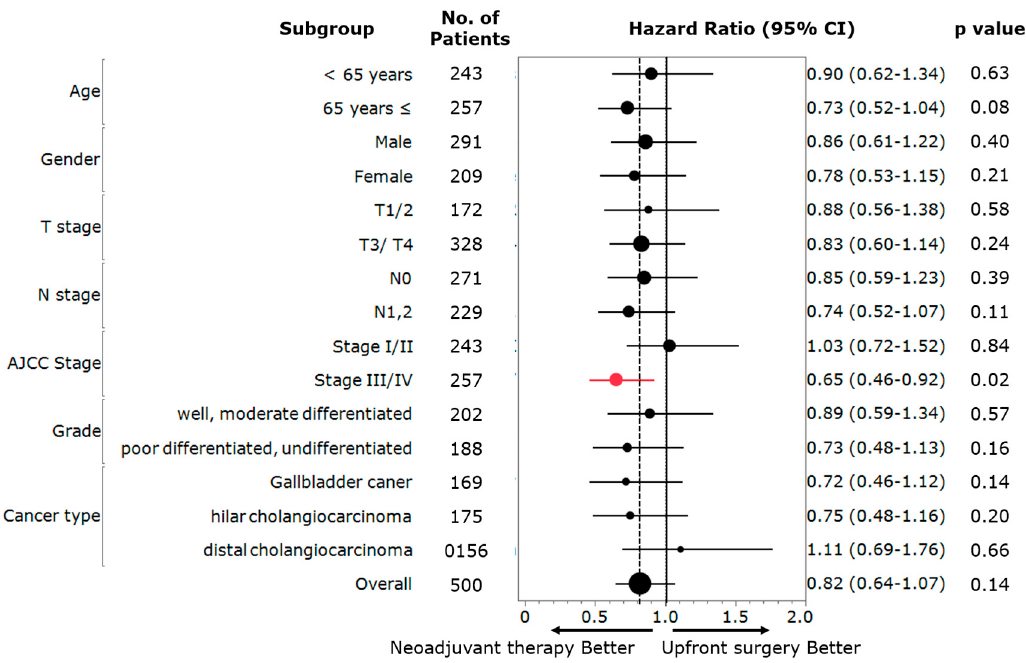
Figure 3. Subgroup analyses of overall survival in the PSM population. HR: hazard ratio; CI: confidence interval.